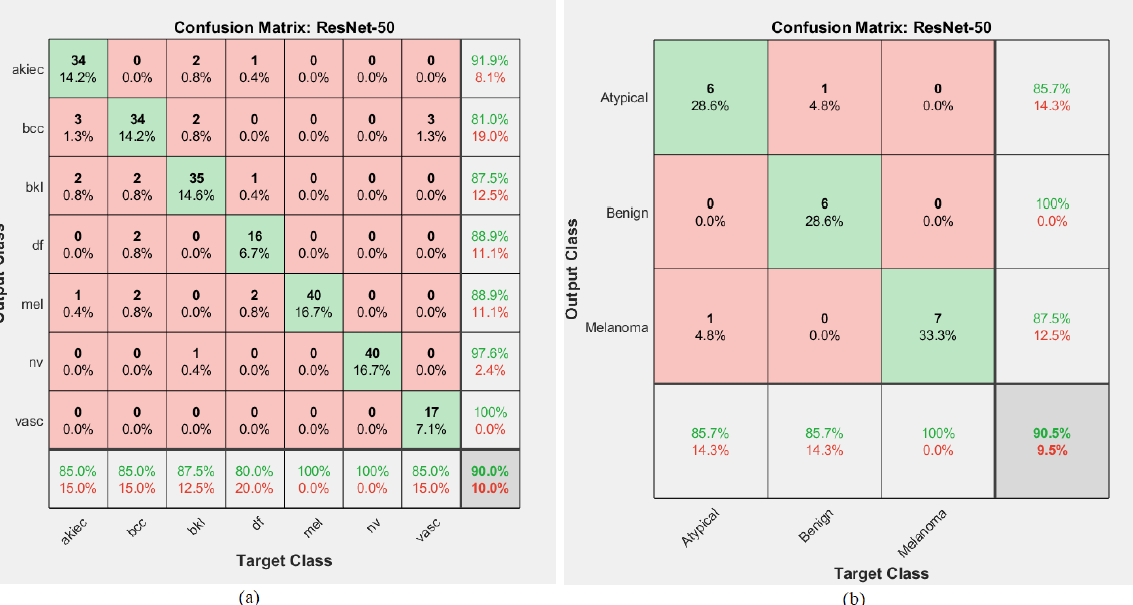
Figure 18. Confusion matrices for the ResNet-50 model considering the different datasets used. ( a ) The ISIC 2018 dataset. ( b ) The PH2 dataset.